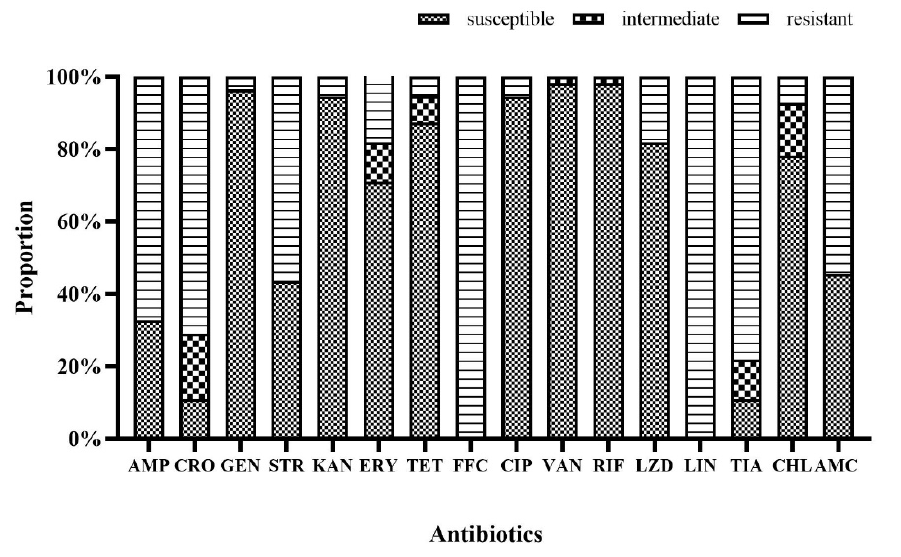
Figure 4. The proportions of susceptible, intermediate and resistant strains among 55 isolated Bacillus strains to 16 antibiotics. AMC: ampicillin, CRO: ceftriaxone, GEN: gentamicin, STR: streptomycin, KAN: kanamycin, ERY: erythromycin, TET: tetracycline, FFC: florfenicol, CIP: ciprofloxacin, VAN: vancomycin, RIF: rifampicin, LZD: linezolid, LIN: lincomycin, TIA: tiamulin, CHL: chloramphenicol, AMC: amoxicillin + clavulanate. Table 2. Proportion of Bacillus strains of different species resistant to antibiotics.